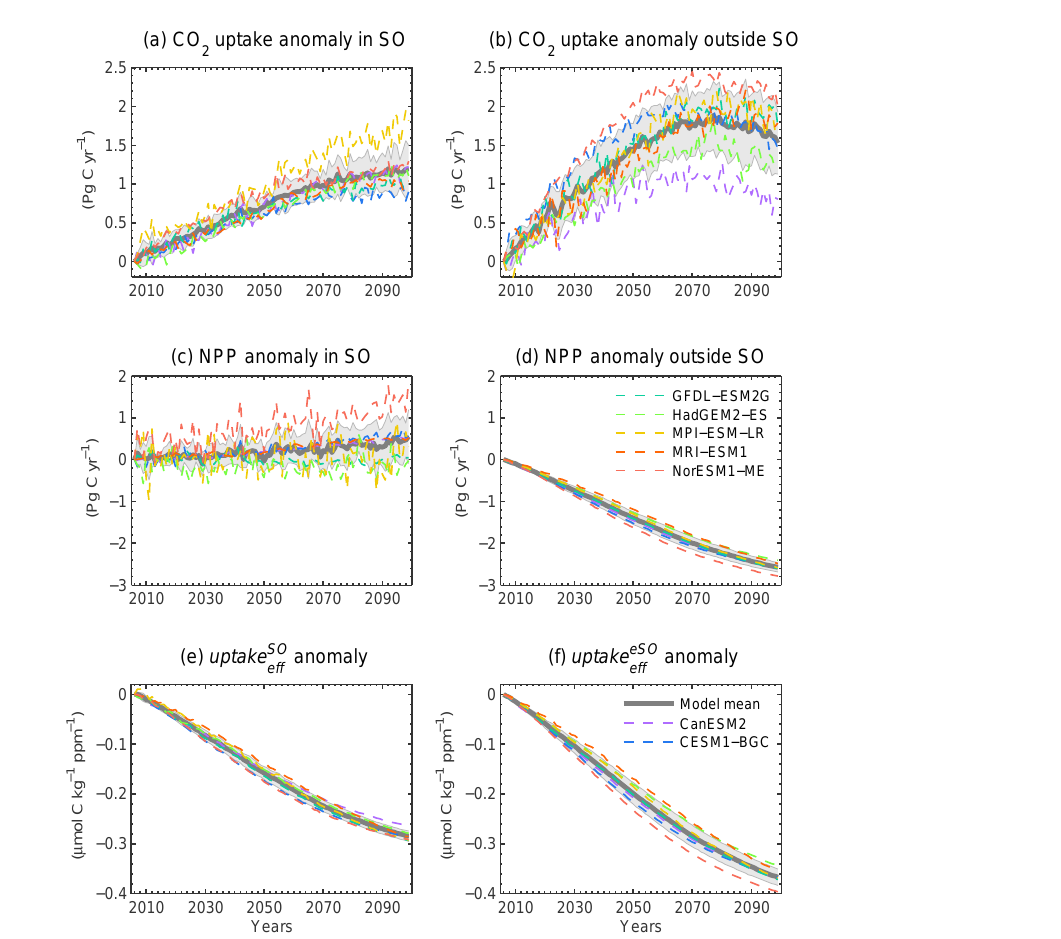
Figure 6. Time series of anomalies (relative to the year 2001) of annual mean (a) carbon uptake, (c) net primary production, and (e) carbon uptake efficiency in the Southern Ocean. Panels (b) , (d) , and (f) also show the same fields as the panels on the left but for the ocean region outside of SO. Thick gray lines represent the inter-model mean, with gray shadings representing ± 1 standard deviation of inter-model